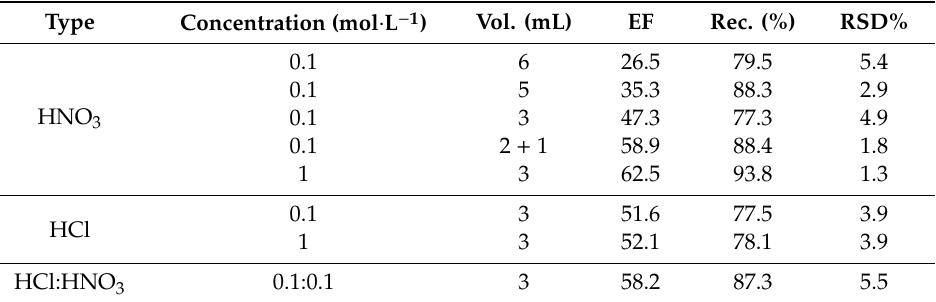
Table 1. E ff ect of type, concentration, and volume of eluent on enrichment factor (EF) and